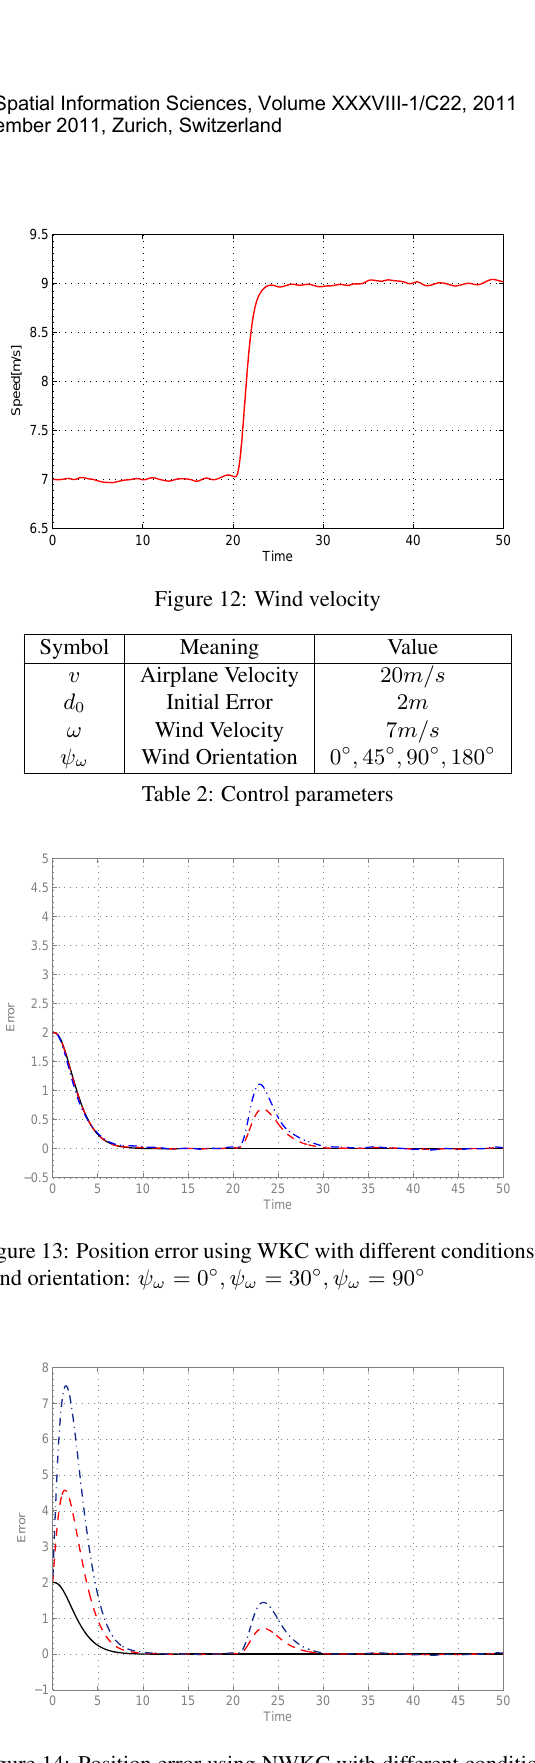
Figure 14: Position error using NWKC with different conditions of wind orientation: ψ ω = 0 ◦ , ψ ω = 30 ◦ , ψ ω = 90 ◦ when computing the airplane orientation to resist to the wind as input for the flight planning. The WCC controller allows the air- plane to stay close to the path as long as the wind does not change its values. The path deviation remains small even for small vari- ations of wind